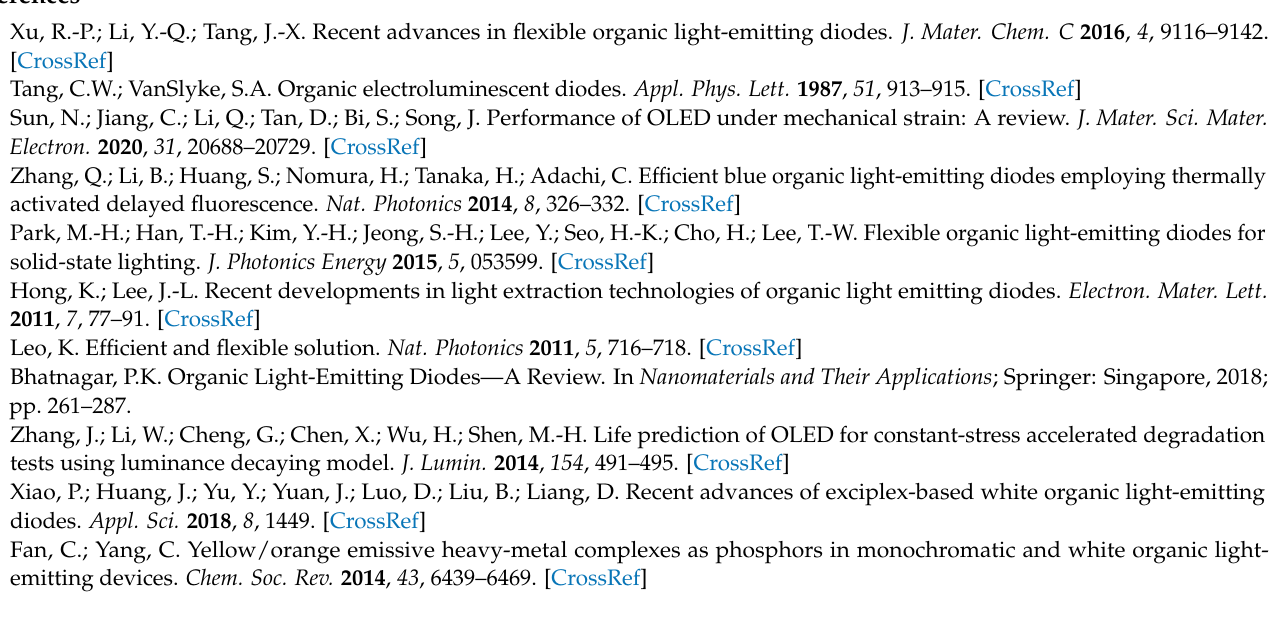
Figure S3: Normalized spectrum with changing viewing angle; Figure S4: CIE’ 1931 color coordinate emission of fabricated OLEDs as a function of the viewing angle; Figure S5: 45 ◦ tilted SEM image according to O 2 plasma and CHF 3 plasma treatment time. (O 2 time/CHF 3 time); Table S1: Re- calculated EQE using viewing angle